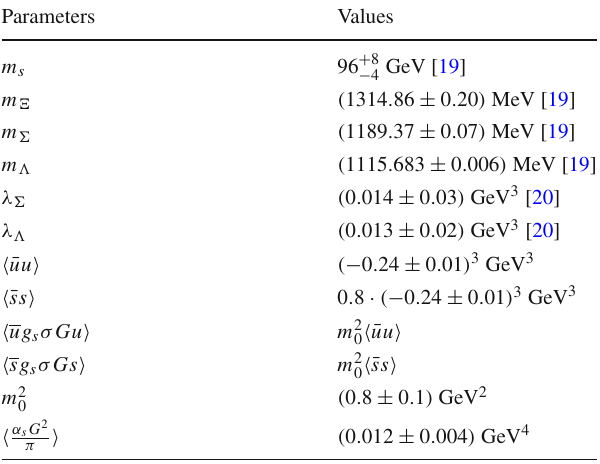
Table 1 Some input parameters used in the calculations Parameters